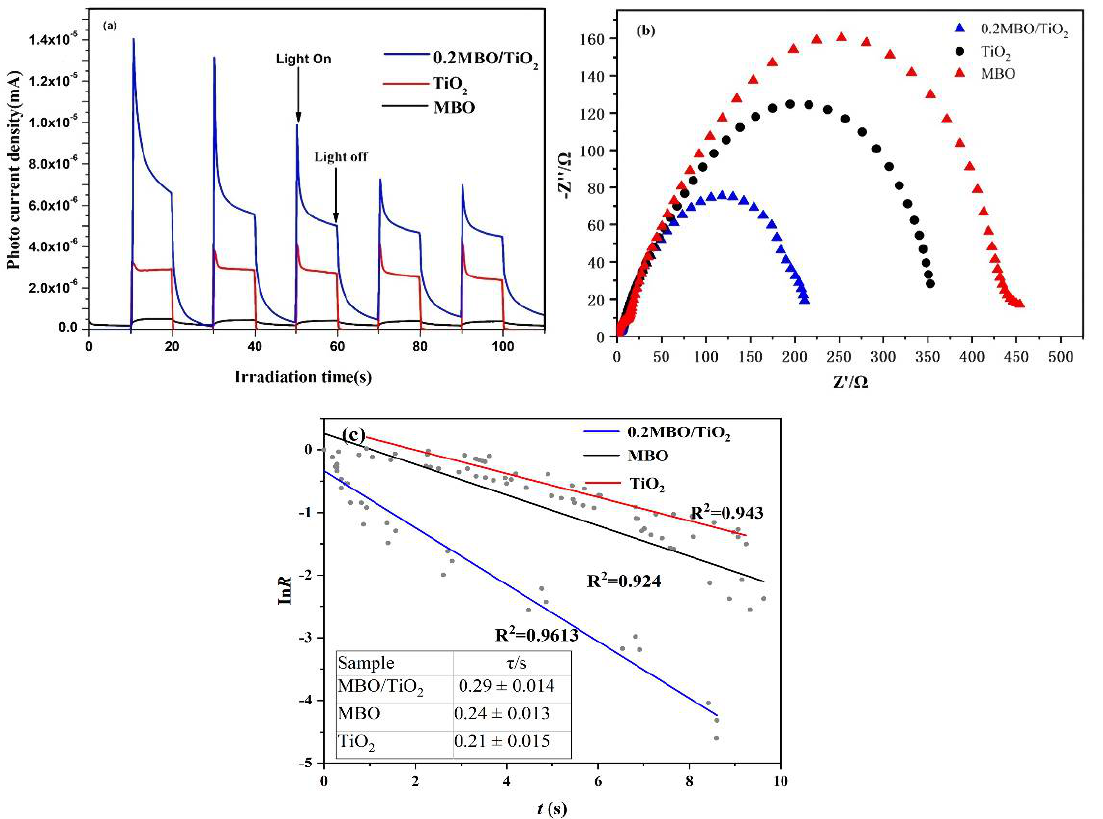
Figure 6. ( a ) Transient photocurrent curves, ( b ) EIS plots, and ( c ) normalized plots of current–time dependence of the MBO, TiO 2 and 0.2 MBO/TiO 2 catalysts, together with the corresponding transient time constants, as shown in the inserted table.